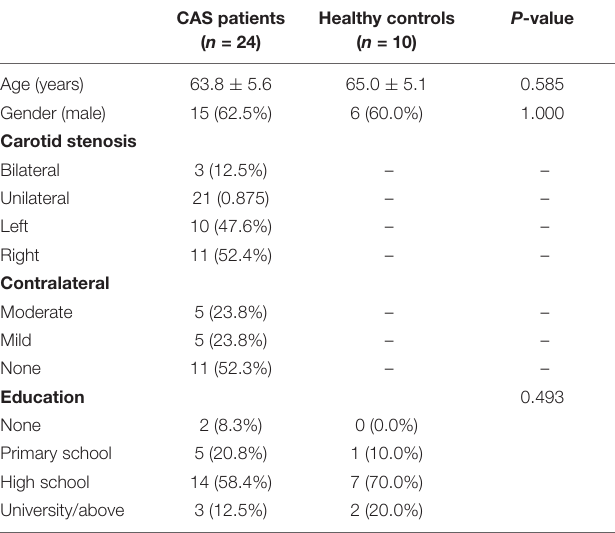
TABLE 1 | Basic information of CAS patients and healthy controls.